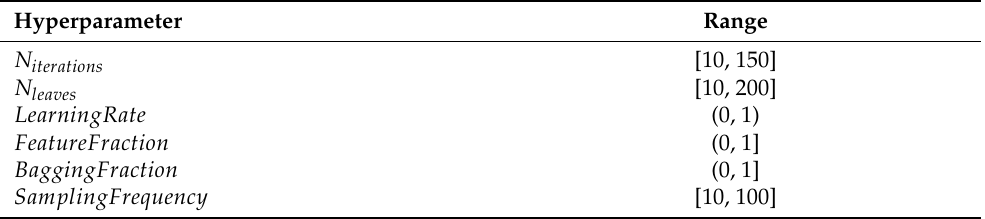
Table 1. Hyperparameters ranges for validation